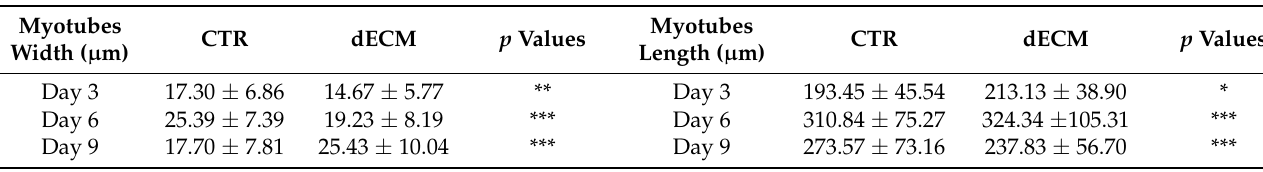
Table 1. Comparison of the morphological features (width, left and length, right) of myotubes originated from C2C12 cells grown on plastic plates either uncoated or coated with dECM. Values are expressed in micrometers mean ± SD and were obtained from a minimum of 70 myotubes. * p < 0.05, ** p < 0.01, *** p < 0.001.